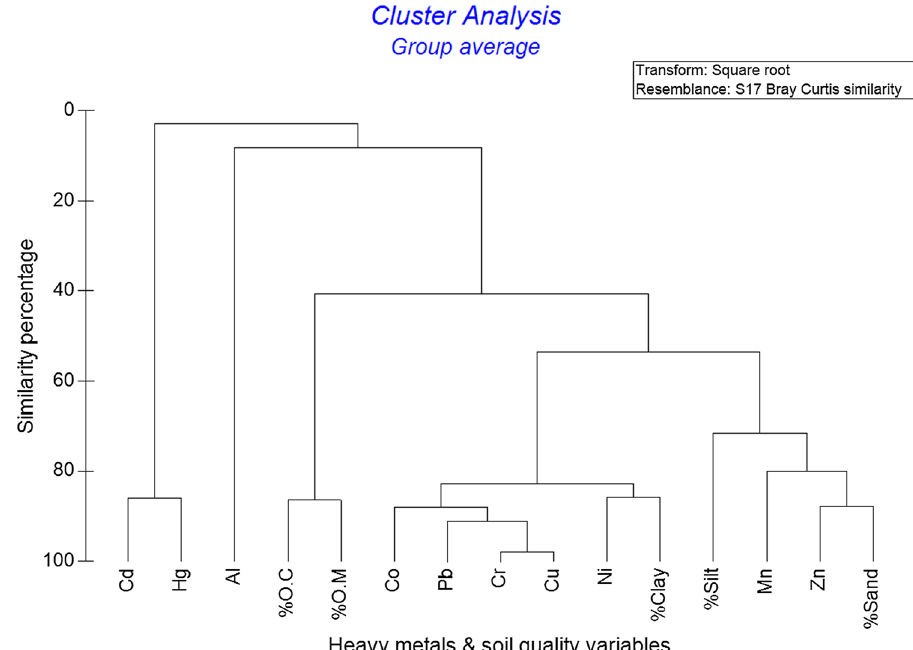
Fig. 5 Dendrogram showing the percentage of similarity among heavy metals and soil quality variables in sediment during different seasons [OC = organic carbon; OM = organic